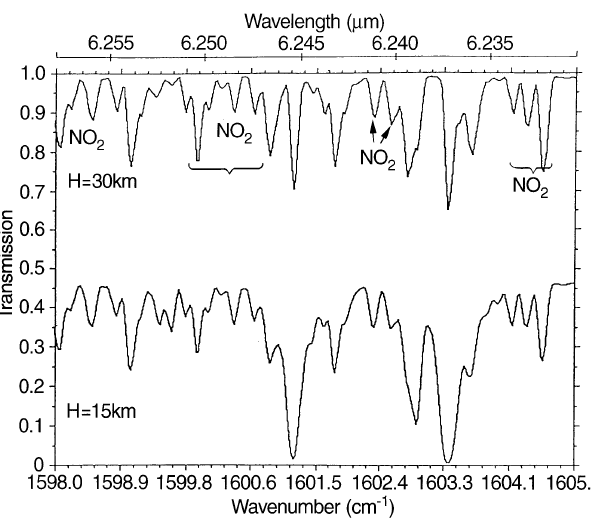
Fig. 8a, b. Simulated ground-based atmospheric spectrum in the 2911 — 2916 cm (cid:126)(cid:49) spectral range, containing characteristic NO (cid:50) ab- sorptions, a at solar zenith angle (SZA) " 26 ° , b at SZA " 76